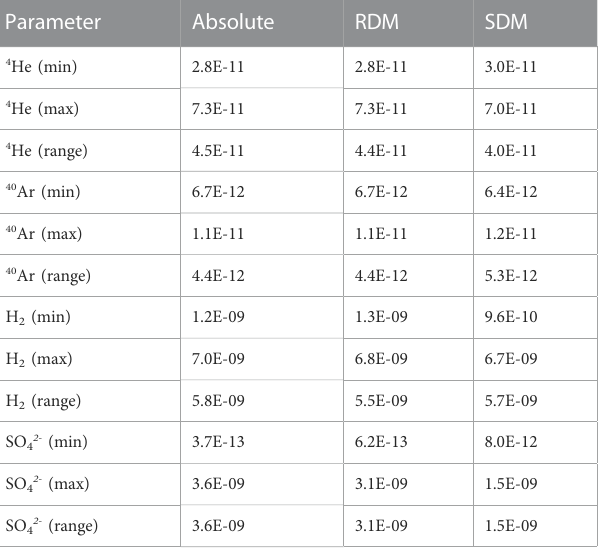
TABLE4Comparingtheminimum,maximum,andproductionratesandranges for three approaches: A) The absolute upper and lower values calculated using maximum and/or minimum values from the input ranges given in Table 1. B) The values generated by the RDM. C) The values generated by the SDM. The RDM and SDM ranges for each element are plotted on Figure 1. Both model results represent 1,000,000 values as discussed in the main text and the maximum and minimum values are also provided in Table 2. These results demonstrate that the RDM generates ranges which are most consistent with those calculated by taking the upper/lower values from the ranges. All production rates are in moles per bulk m 3 per